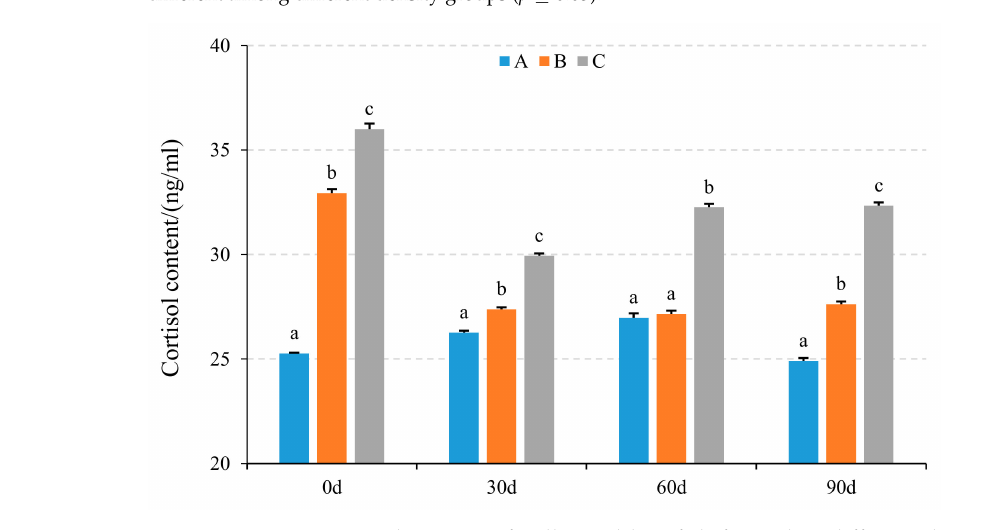
Figure 1. Serum cortisol content of yellowtail kingfish farmed in different densities during the whole study. Notes: A represents the low-density group, B represents the medium-density group, C represents the high-density group. Different lowercase letters indicate significant differences among the three different density groups at each sampling time ( p ≤